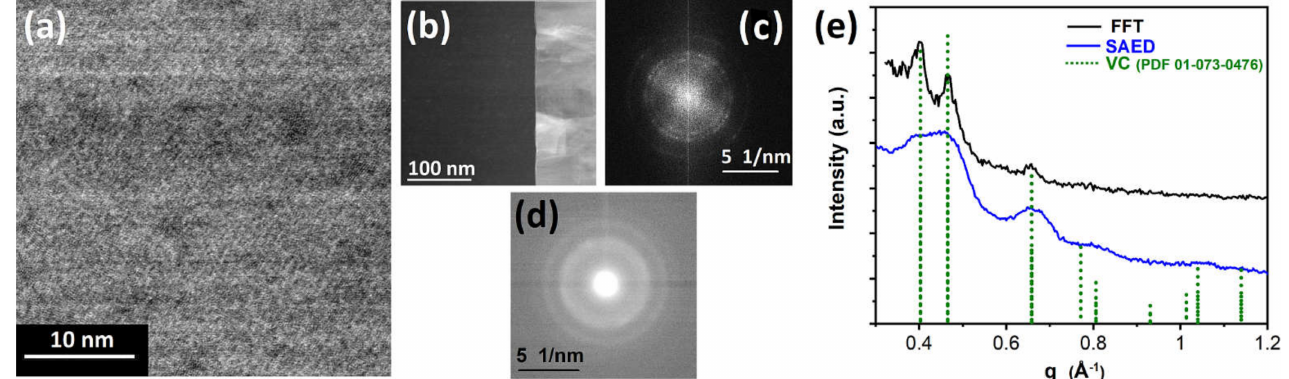
Figure 3. ( a ) High-resolution bright-field image of the V-based FEBID material shows phase/diffraction contrast suggesting particle sizes in the range of 2–5 nm. The high-resolution image is part of a lamella prepared from a ~200 nm thick FEBID deposit written on top of a gold layer, as illustrated in ( b ) with the brighter Au layer in this high-angle annular dark-field image (HAADF). ( c ) The fast Fourier transform image using the TEM image in ( a ) is reduced to the central, significant part illustrating specific ring structures, which can be supported by ( d ) nanobeam electron diffraction images providing information on the crystalline fraction of the FEBID material. ( e ) The graphic representation of information as a rotational profile that can be extracted from ( b , d ) allows the assignment of a crystal phase, such as VC, which can be also described as a generalized solid-solution VC 1 − x O x